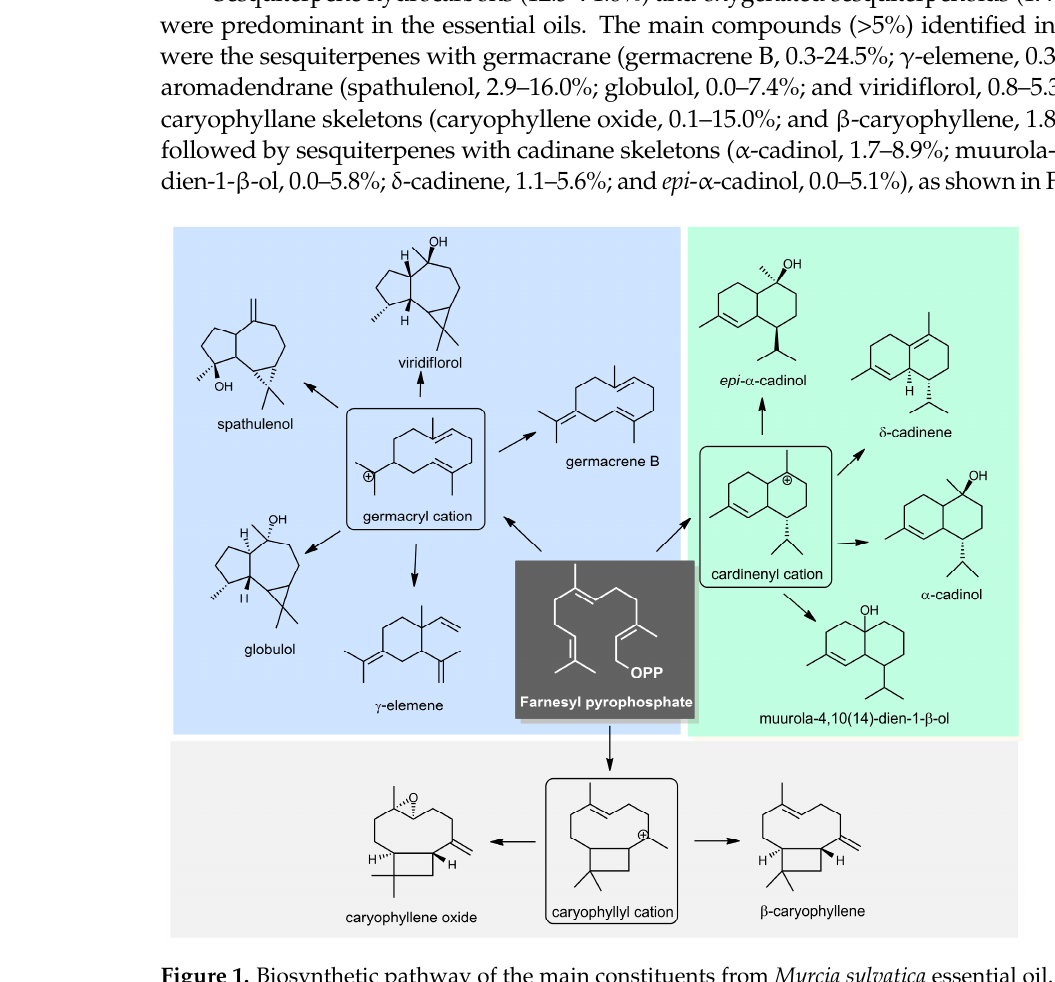
Figure 1. Biosynthetic pathway of the main constituents from Myrcia sylvatica essential oil. The seasonal and circadian study of essential oil from leaves and fruits of M. sylvatica collected in the municipality of Santarém, state of Pará, indicated that the yield varied from 0.9 to 1.7% [12], values higher than this work. In contrast, the yield of leaf essential oil from this species collected in Carolina, state of Maranhão, was 0.5% [17], the same content presented by the specimen Msy ‐ 07. In the Myrtaceae species essential oils, the predominance of hydrocarbon and oxygenated sesquiterpenes has been evidenced, some of them with biological properties [18,19]. The presence of the sesquiterpene hydrocarbon β‐ caryophyllene (45.0%) as the major constituent was identified in a M. sylvatica sample collected in Maranhão [17]. Other compounds were also reported as the main compound in oils from Tocantins, among them the oxygenated sesquiterpenes spathulenol (13.8–40.2%) and caryophyllene oxide (5.0–16.6%) [10]. Germacrene B (6.7%) and γ‐ elemene (10.5%) were identified as the highest content in M. splendens [20].